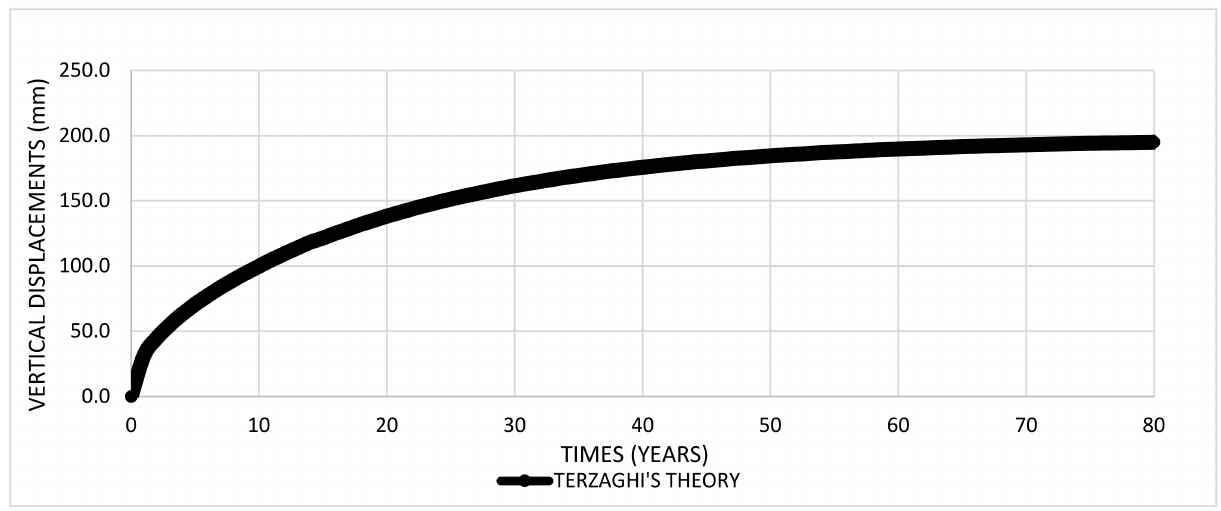
Figure 5. Expected displacement curve for soil mass over